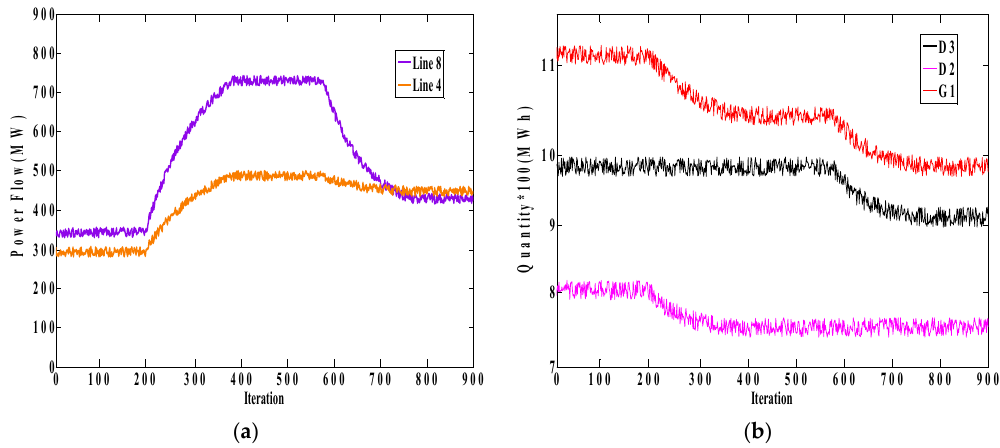
Figure 14. ( a ) Power flows of Lines 4 and 8 in Case B when the limit of Line 8 increases; ( b ) bidding quantity of G1, D2, and D3 in Case B. Energies 2017 , 10 , 2045